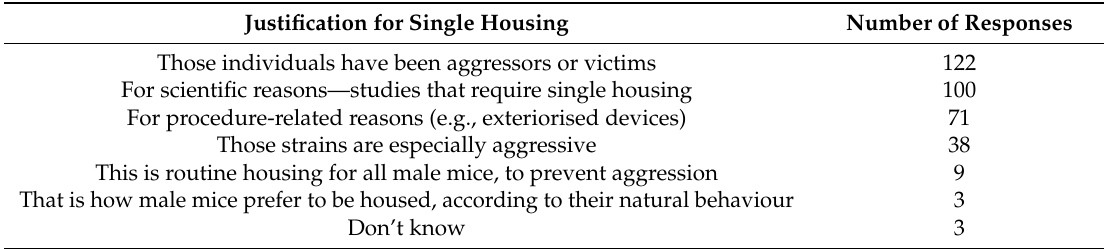
Table 1. Reasons given by survey respondents for singly housing male